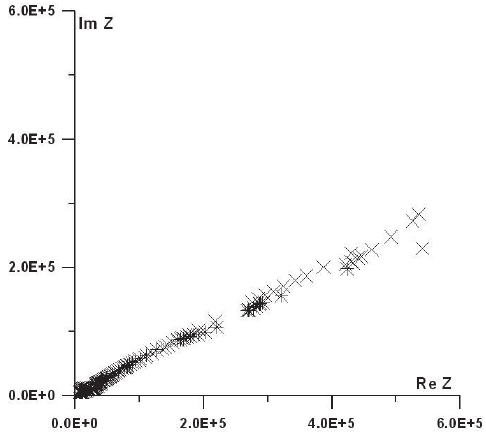
Fig. 7. The complex resistivity plane representation of the sample for relative saturations 32% ( ), 40% ( ), respectively.